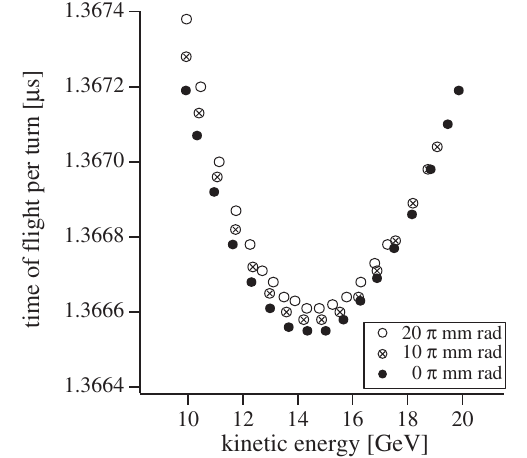
FIG. 1. Time of flight during acceleration for different trans- verse amplitude.